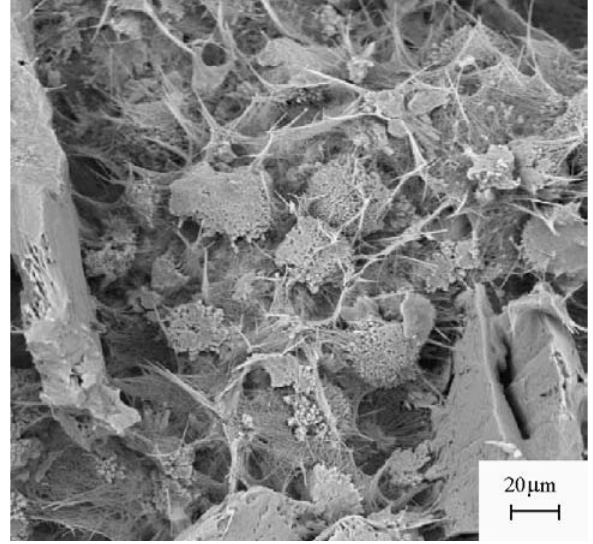
Figure 13. SEM micrograph of the aggregate/paste interface in the (J) samples (CPI-S-32 cement/5% bottom ash/sand) after 28 days of aging.